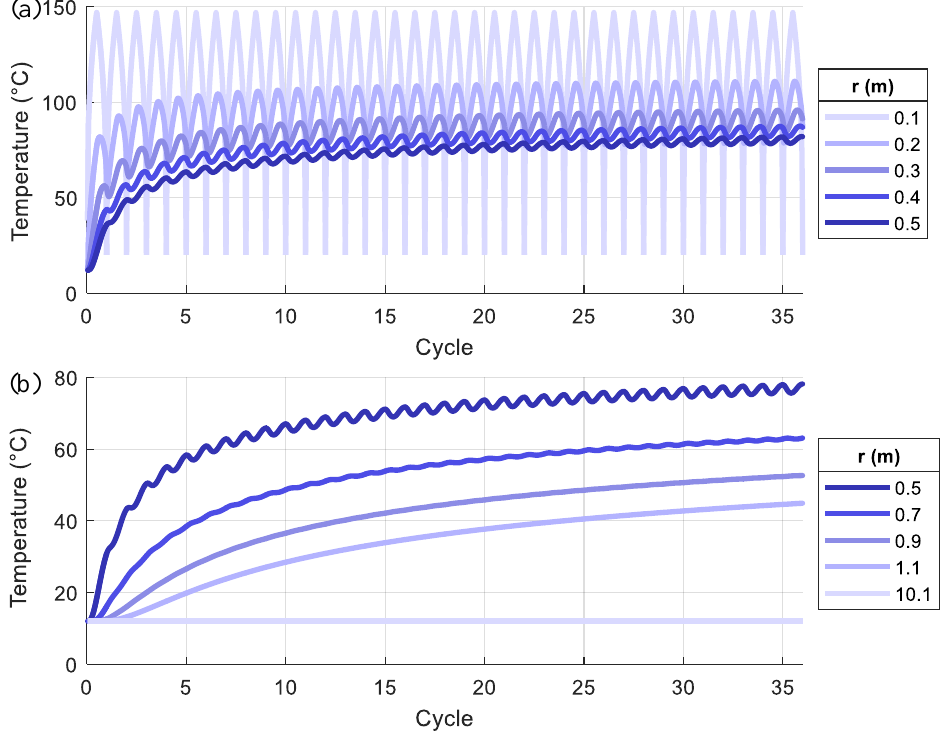
Figure 10. Temperature history for the first 36 loading cycles in the: ( a ) concrete; ( b ) soil.